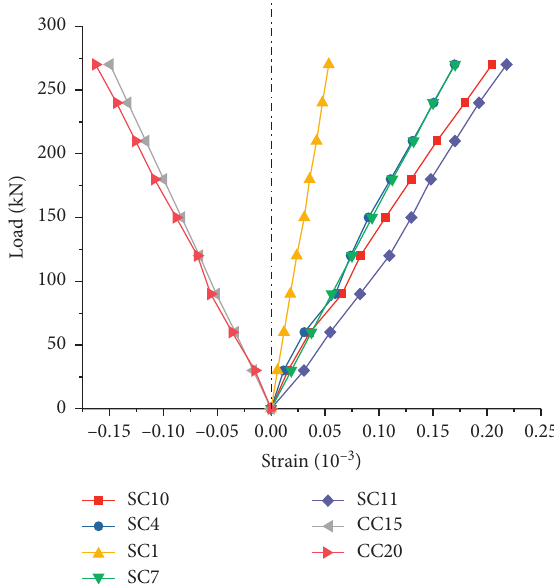
Figure 17: Load-strain relationship of SC-M2 in flexural experiment.